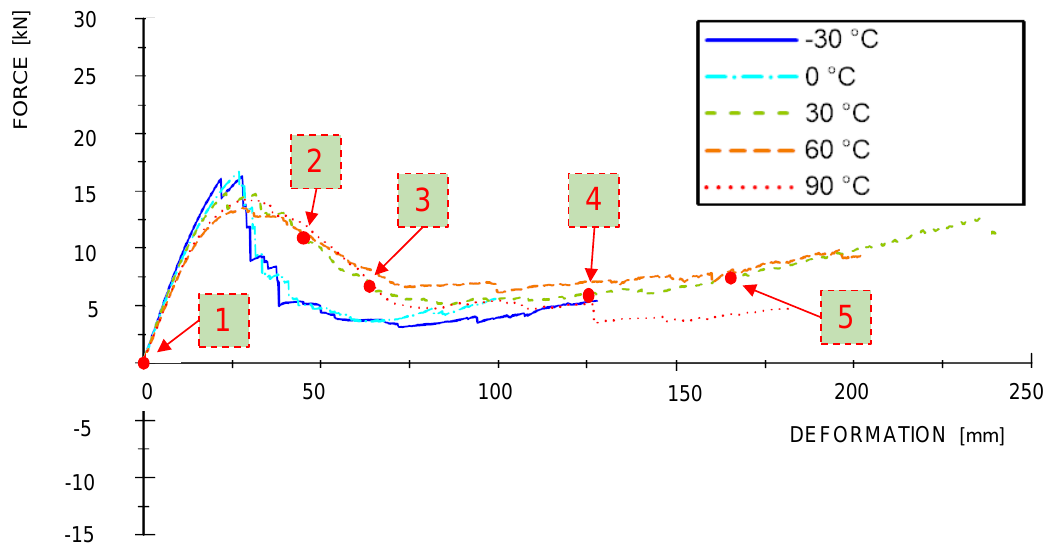
Figure 9. Average force-deformation curves of the quasi-static tests.